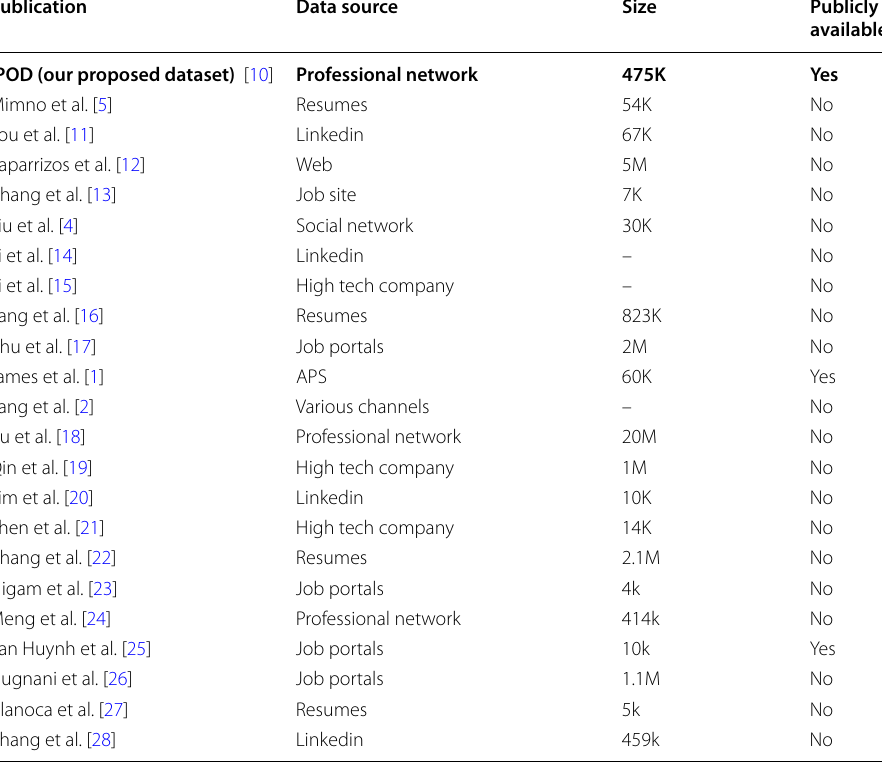
Apart from two datasets of comprising publications and authors [1] and job titles and descriptions [25], there are no publicly available occupational-related dataset from our survey. The first dataset [1] contains publications and authors from the American Physics Society (APS) but only describes the names and affiliations of physics scientists without their job title or appointments, while the second dataset [25] contains the job title and job description from a job portal but only pertaining to IT-related jobs. Our proposed dataset, IPOD is bolded and in the first